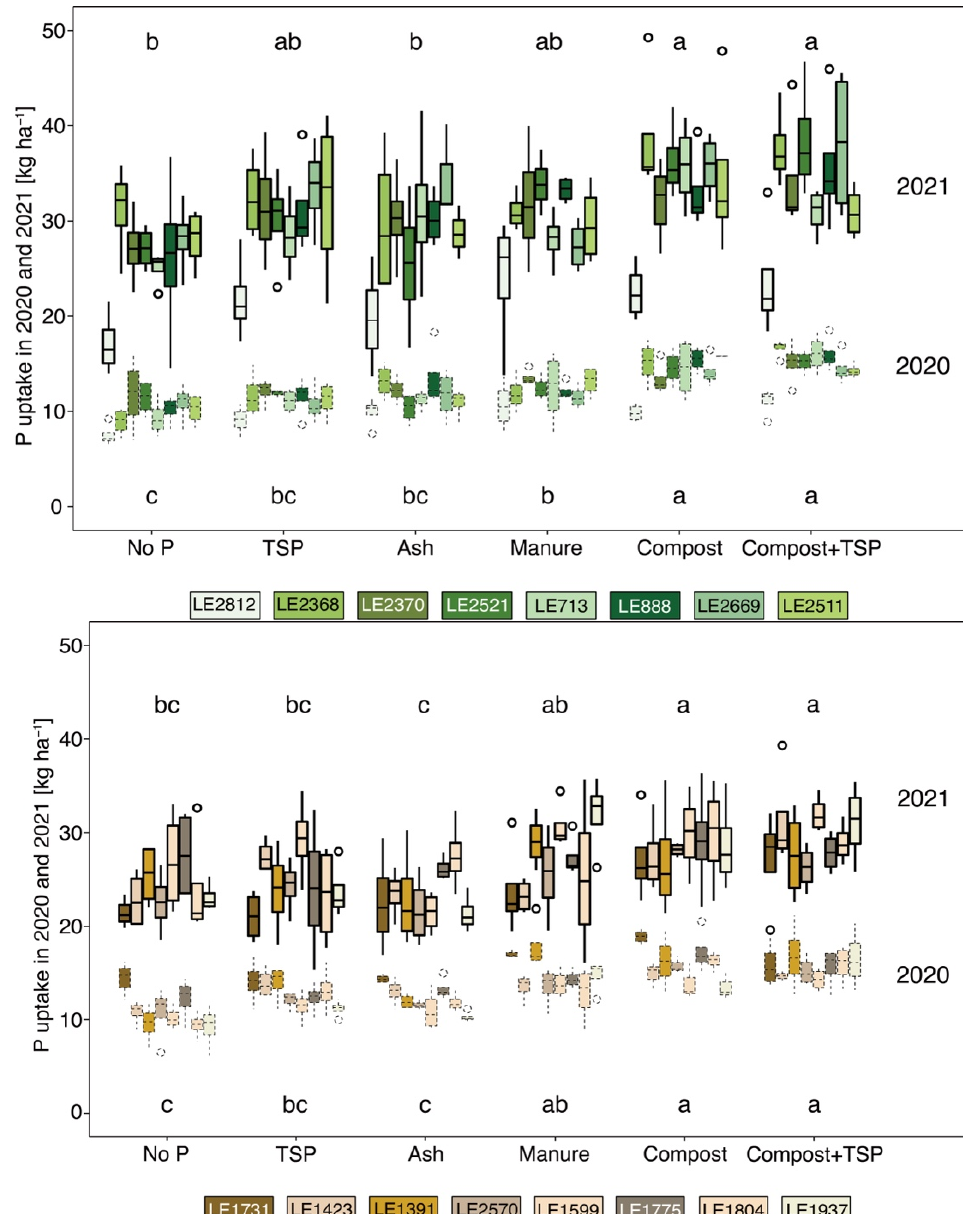
Figure 3. Plant phosphorus (P) uptake of selected accessions of alfalfa (upper part) and red clover (lower part) of the six studied treatments (no P, TSP, ash, manure, compost, and compost + TSP) in 2020 and 2021. Alfalfa and red clover accessions are illustrated in different shades of green and brown colours, respectively. The years 2020 and 2021 are differentiated with dotted and solid lines, respectively. Letters indicate a significant difference between treatments (based on the average of accessions) within the same plant species (Duncan’s new multiple range test with p < 0.05). Mean ± standard deviation (n =